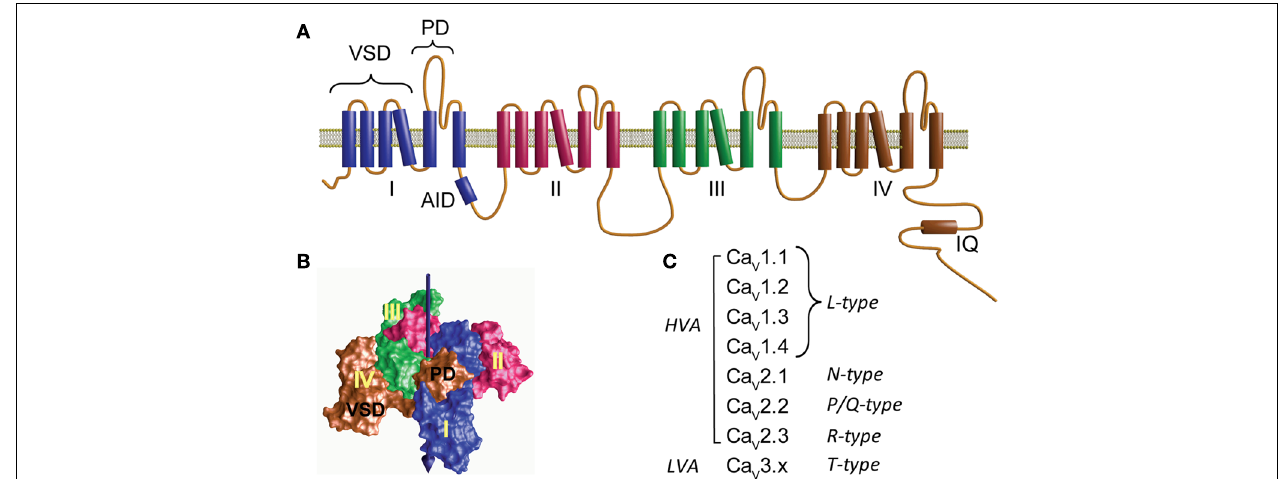
FIGURE 1 | Structure and diversity of the α 1 pore-forming subunit of voltage-activated calcium channels. (A) Membrane topology of the α 1 -subunit. Homologous to voltage-activated sodium channel, Ca consists of four repeats (I–IV) joined by three cytoplasmic loops namely loop I–II, II–III, and III–IV. Loop I–II contains the highly conserved binding site for the β -subunit, referred to as α 1 interaction domain or AID. The C-terminus is relatively large and accommodates the binding site for Ca 2 + /calmodulin (IQ). Each repeat contains six transmembrane helices that include two separate structural domains: the voltage-sensing domain (VSD)